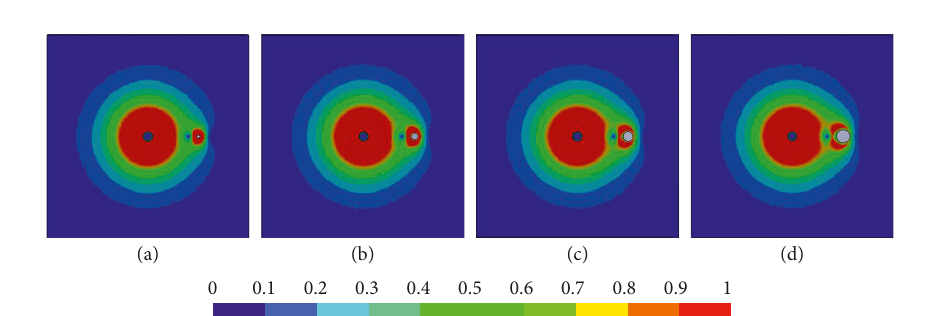
� 0.5, (b) r � 1, (c) r � 1.5, and 2 / r 1 2 / r 1 2 / r 1